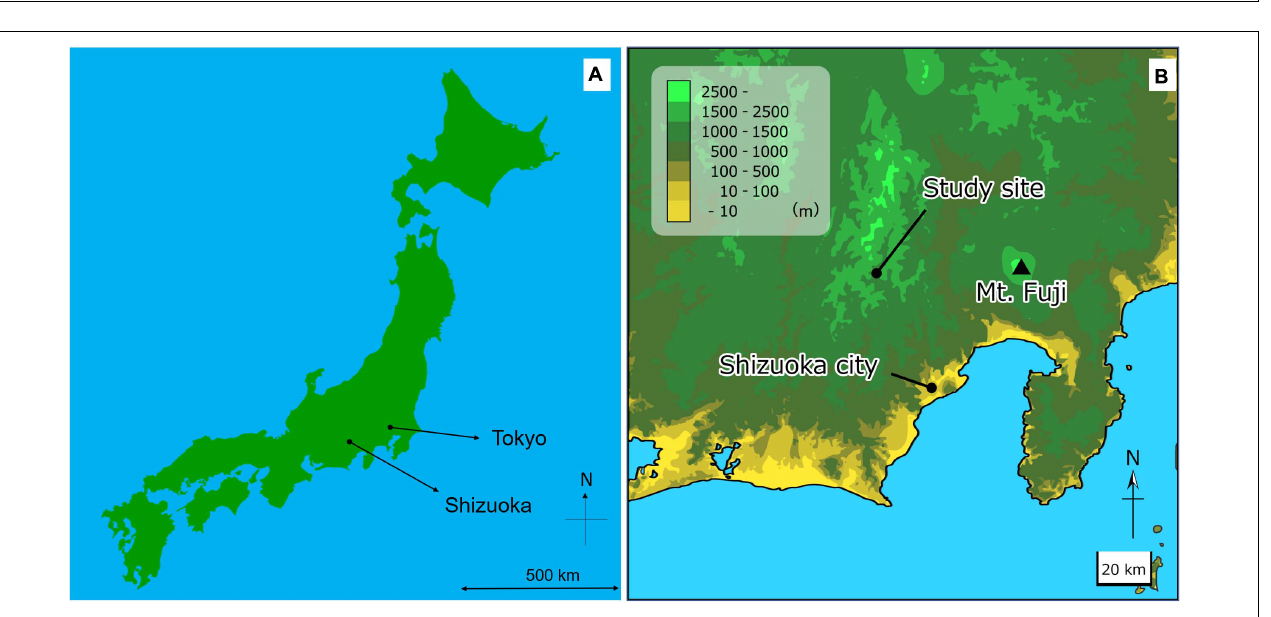
FIGURE 1 | Schematic diagram of bark surface and photographs of the bark of target tree species. The upper row is a schematic drawing of the bark surface, (A) smooth and mottled surface type, (B) smooth lateral skin type, (C) moderate roughness type, (D) coarse and deep longitudinal tear type, (E) moderate type of conifer, and (F) coarse type of conifer. The middle row shows bark photographs of the trees in which soaking experiments of the bark were conducted, (G) Clethra barbinervis, (H) Padus grayana, (I) Magnolia obovata, (J) Castanea crenata, (K) Abies firma, and (L) Tsuga sieboldii.